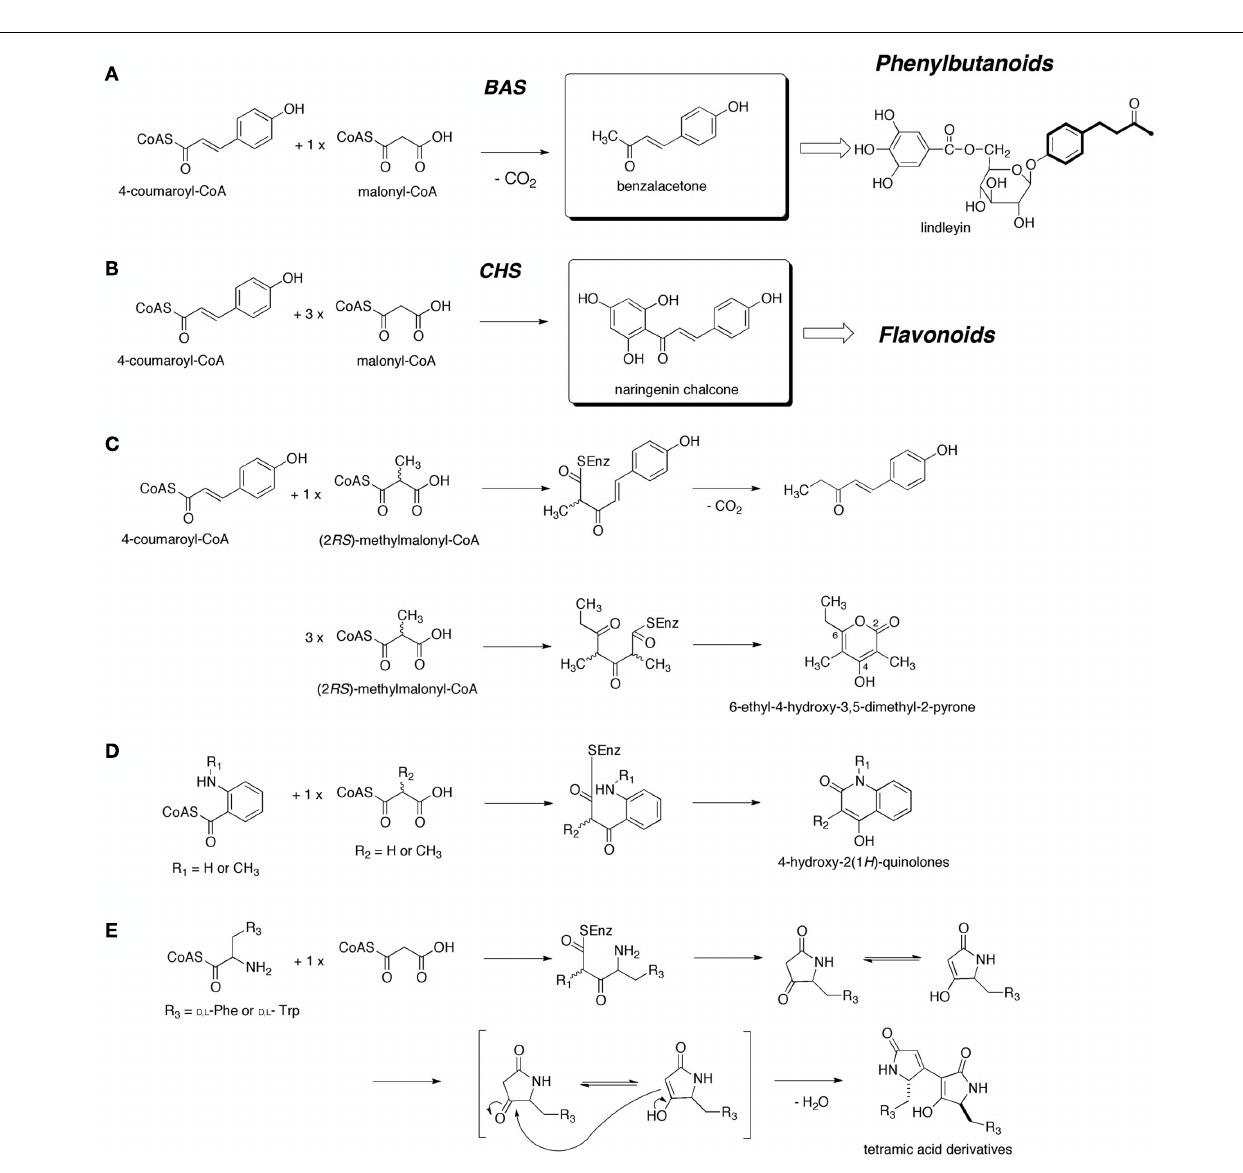
FIGURE 1 | (A) The proposed mechanisms for the formation of benzalacetone by R. palmatum BAS, and naringenin chalcone by CHS.The proposed mechanisms for the formation of (B) the C 6 –C 5 diketide, (C) the methylated C 9 triketide pyrone, (D) the diketide quinolones, and (E) the diketide tetramic acid derivatives by R. palmatum